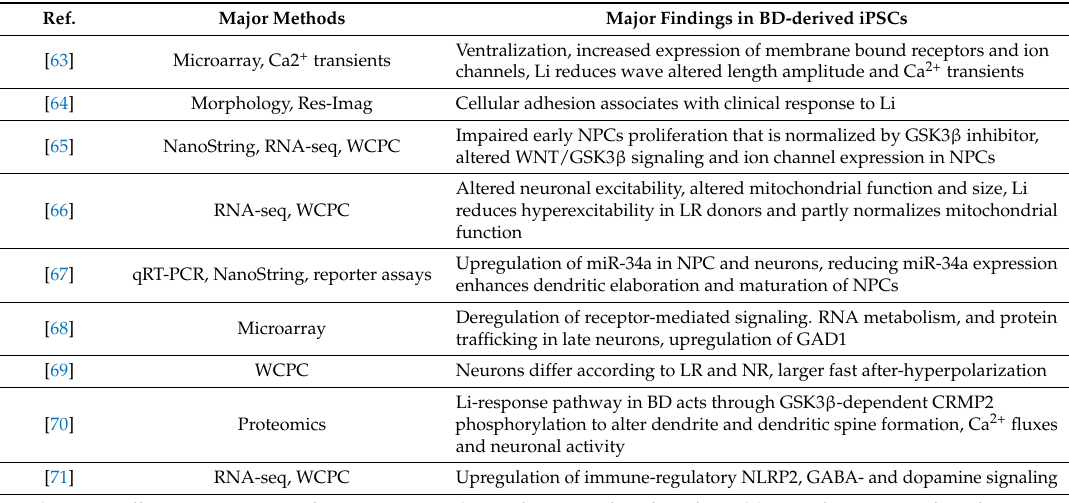
Table 3. Major analytical methods and findings in BD-derived